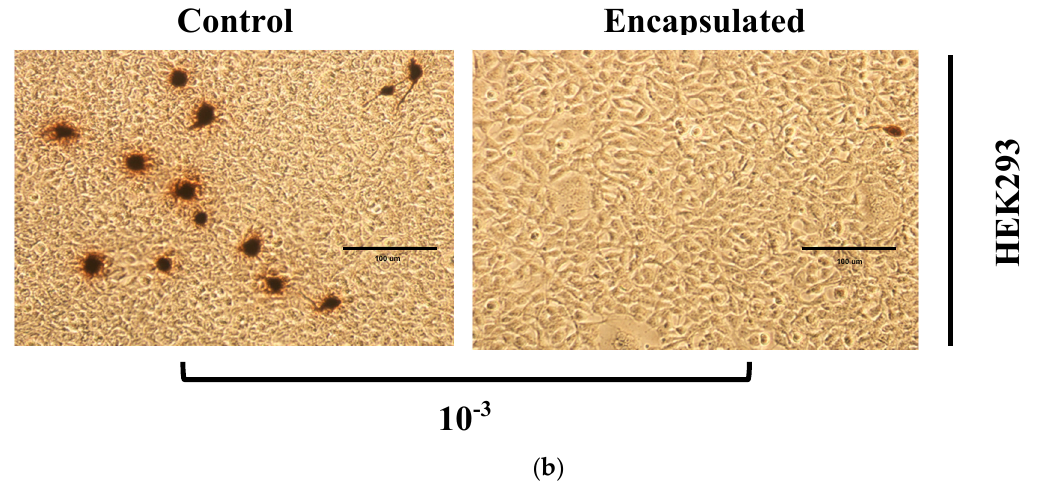
Figure 8. Encapsulation efficiency (EE) of adenovirus into γ‐ PGA ‐ chitosan NPs; ( a ) EE evaluated by measuring the difference of Ad infectivity in the supernatant and the control. Difference refers to the amount of encapsulated Ad inside the particle, which means the pellet after centrifugation containing Ad. ( b ) HEK293A cells infected with supernatant containing Ad from the same dilution of the control and NP suspension. Black dots represent cells infected with Ad, and titers were calculated according to the Adeno ‐ X Rapid Titter Kit manufacturer instructions. Magnification power ×200, scale bar 100 μ m. Experiments were conducted in triplicate ( n = 3).